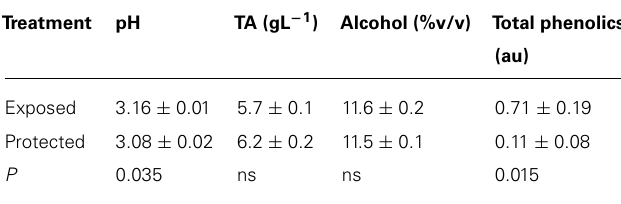
bunches from vines grown in exposed conditions and compared with protected bunches covered by shade cloth during the 2008/09 growing